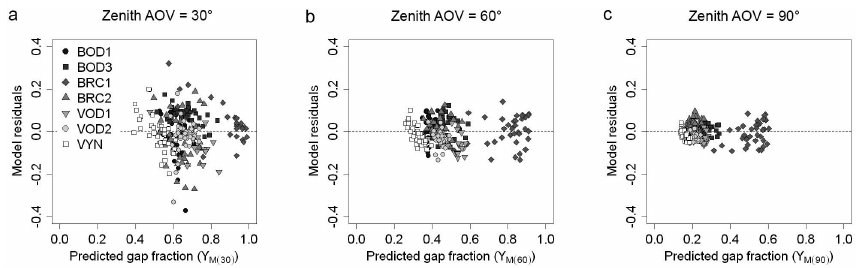
Fig. 6. Relationship between gap fraction predicted from multiple linear regression (Eq. 4) ( Y M(θ) ) and model residuals (FGF θ − Y M(θ) ) for three representative zenith angle AOV.